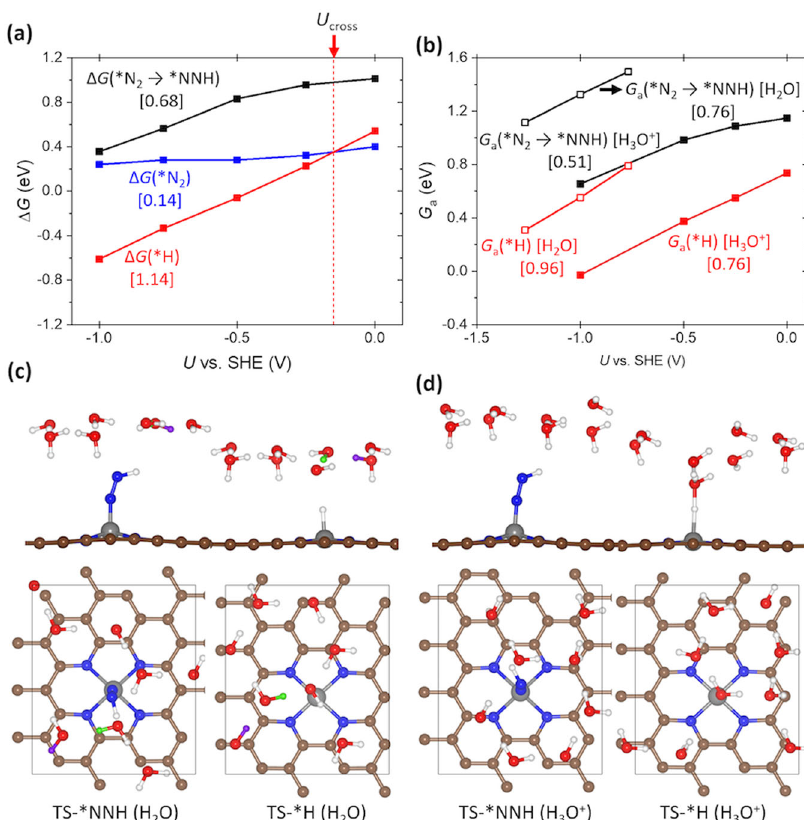
Fig. 4 Potential-dependent energetics of *H, *N 2 , and *NNH formation. a Change of Δ G (*N 2 → *NNH), Δ G (*N 2 ), and Δ G (*H) by U . The red vertical dashed line in a represents the crossover potential ( U at Δ G (*H) = Δ G (*N 2 )). b Change of G a (*N 2 → *NNH) and G a (*H) by U . The slope ( Δ G vs. U or G a vs. + as a proton donor, respectively. Black, U ) of each reaction is shown in the graph. Open and closed squares represent G a obtained by using H 2 O and H 3 O blue, and red lines represent reaction energetics for *NNH, *N 2 , and *H formation, respectively. The optimized transition state geometries of *NNH formation and *H formation c at 0 V vs. RHE (pH = 13) by using H 2 O and d those at − 0.5 V vs. RHE (pH = 0) by using H 3 O +